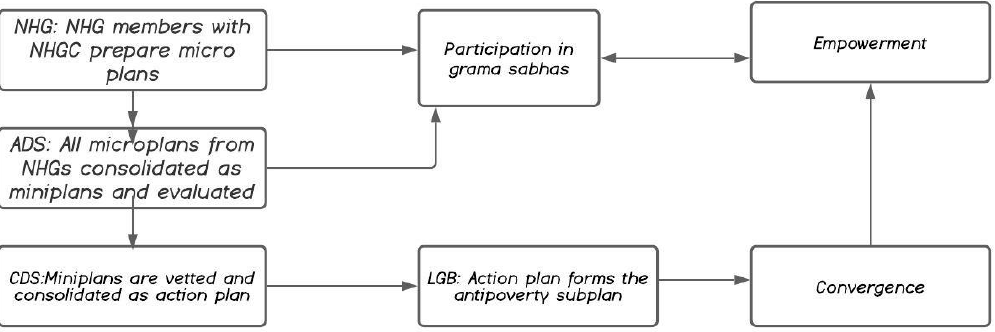
Figure 1. Community Based Organization process of decision making. Notes: NHG = neighborhood group; NHGC = neighborhood group committee; ADS = Area Development Society; CDS = Community Development Society; LGB = local governing bodies.